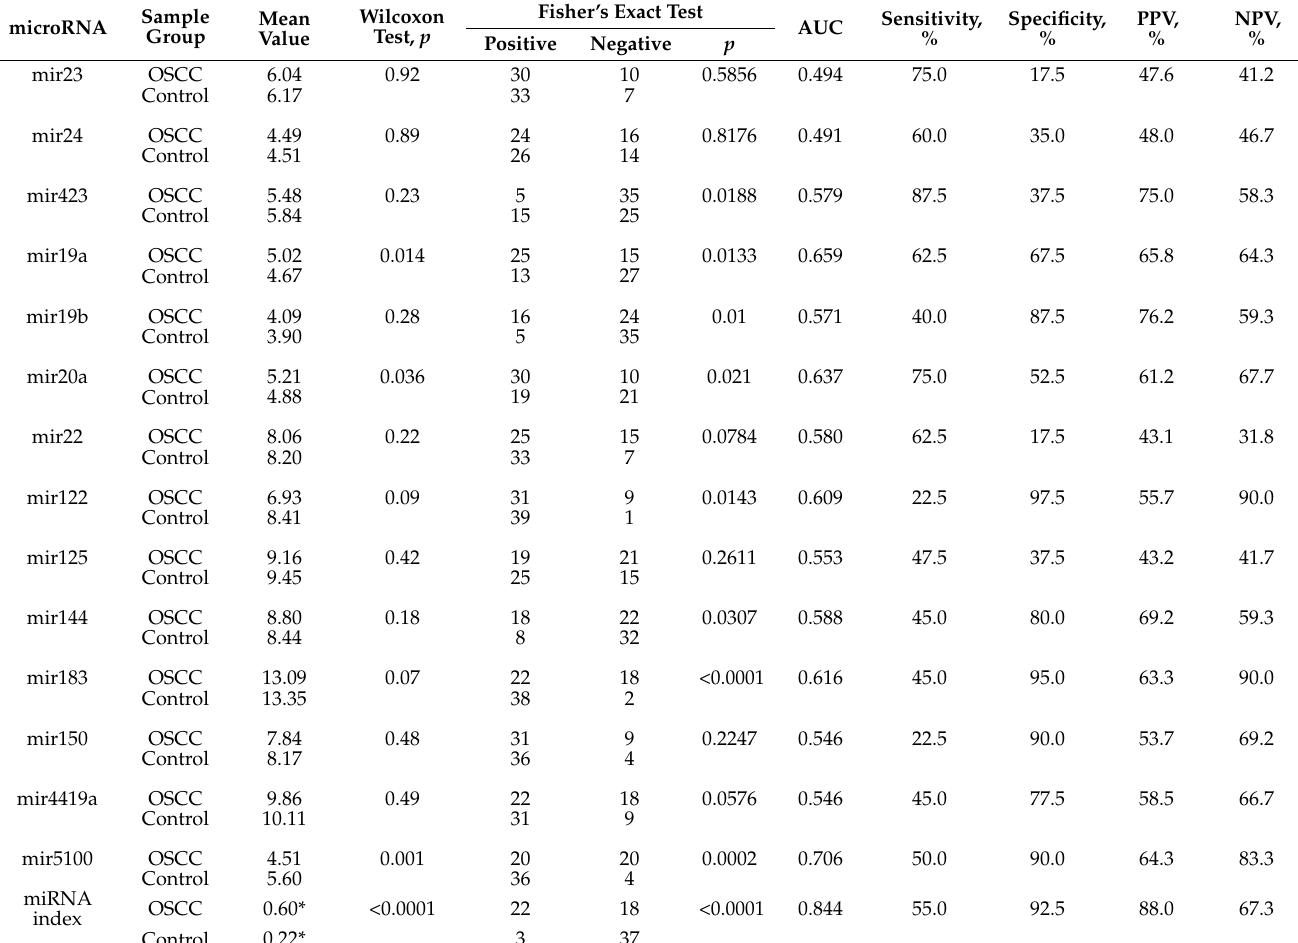
Table 2. Diagnostic performance of miRNAs in oral squamous cell carcinoma (OSCC) detection using cutoff values.